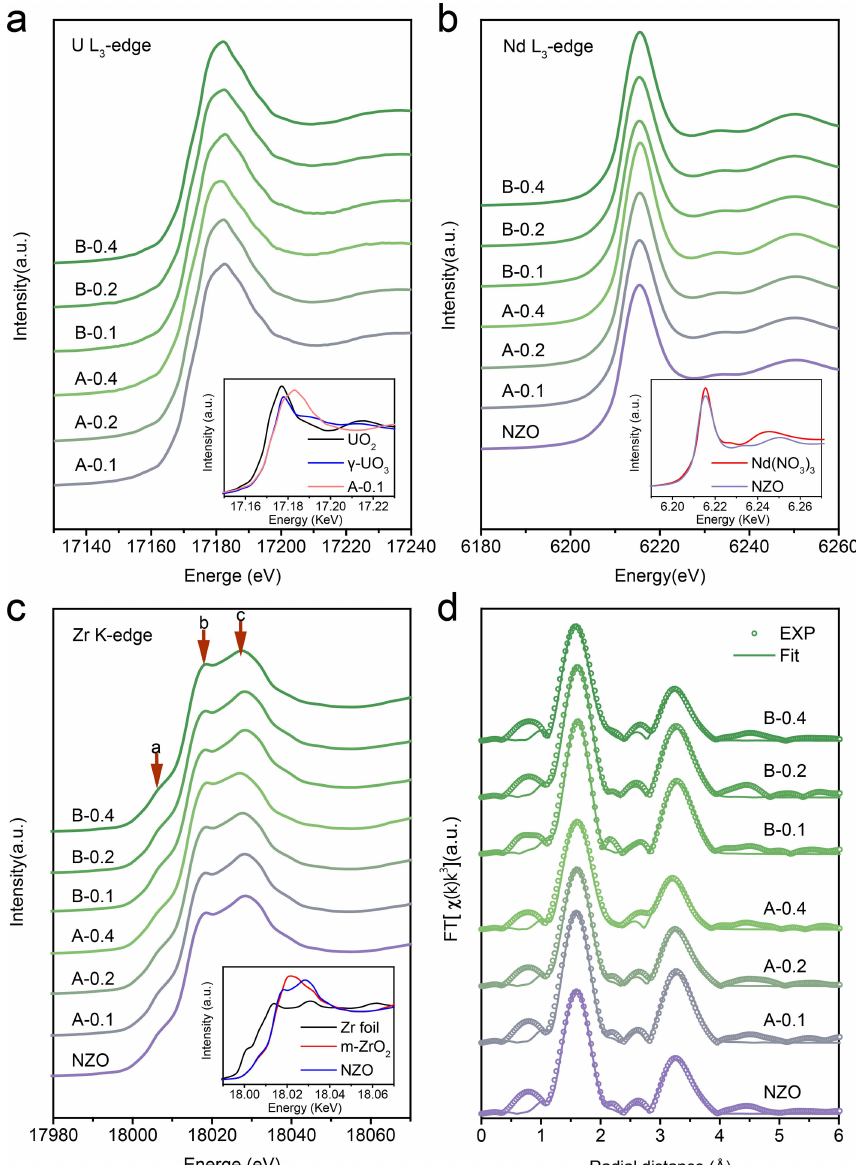
Figure 3 XAFS data of the NZO and U-doped NZO samples. ( a ) U- L 3 , ( b ) Nd- L 3 and ( c ) Zr K -edge XANES spectra of U-doped NZO samples, ( d ) Fourier transform (FT) of Zr K -edge EXAFS data and their corresponding fits in R